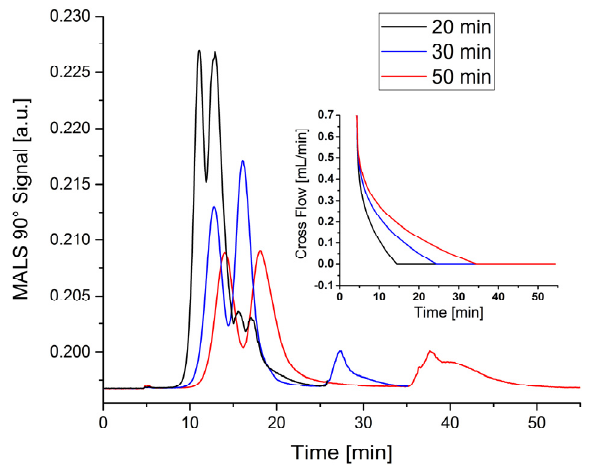
Figure 2. Fractograms of polystyrene nanoparticle mixture 7 (see Table 4) recorded at different elution times using the miniaturized channel. Insert shows cross flow profiles, MALS 90° detector.